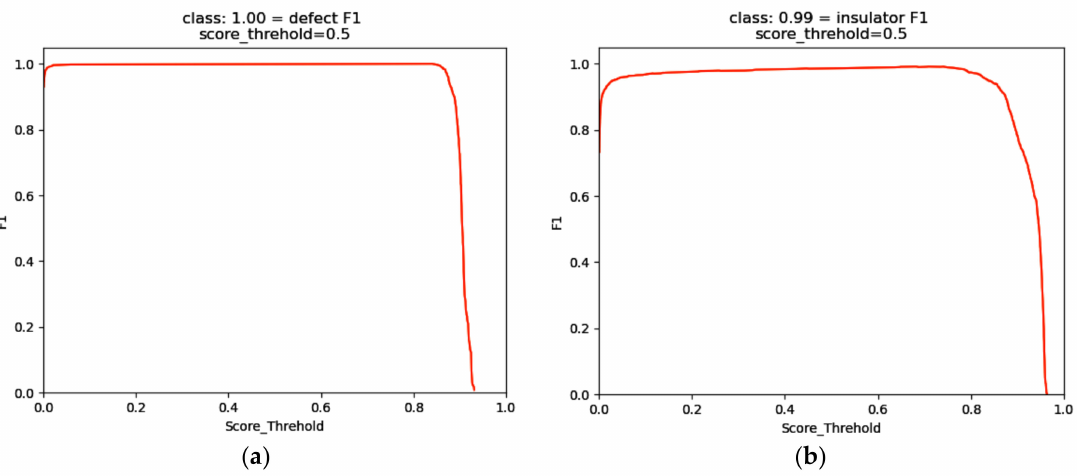
Figure 8. The F 1 score curve of defective and normal insulators: ( a ) F 1 score curve of defective insulators, ( b ) F 1 score curve of normal insulators.